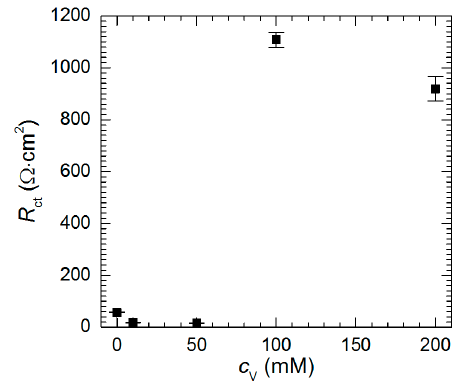
Figure 12. Charge-transfer resistance as a function of initial concentration of sodium orthovanadate in H 2 SO 4 solution, pH = 1.3, t = 576 min, T = 303 K. The increase of the surface area of the electrode caused by selective corrosion can be easily monitored using the double-layer capacitance. The capacitive behavior of the electrical double layer is usually modelled using CPE instead of capacitor due to frequency dispersion. The impedance of the CPE is given by Equation (4) [32]: